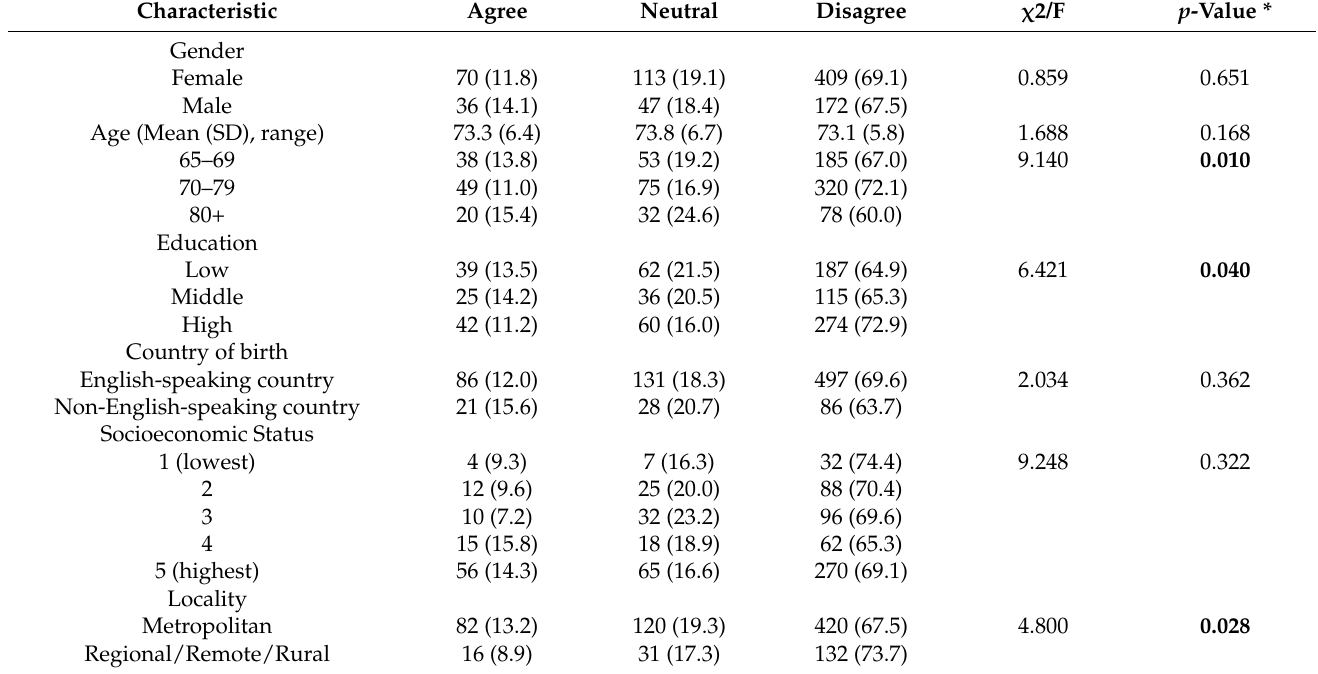
Table 3. Association of demographic variables with the belief that dementia is a modifiable condition.